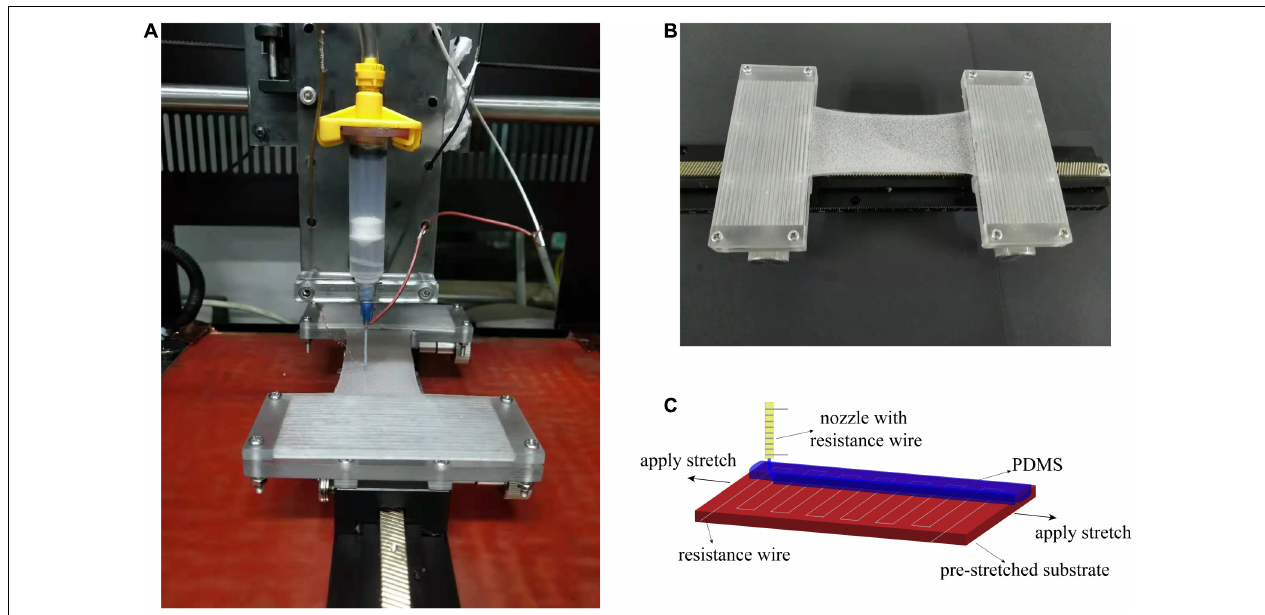
FIGURE 1 | Pre-strained 4D printing platform. (A) 3D movement platform for spatial printing. (B) The clamping device. (C) Schematic of the 4D printing with a pre-strain